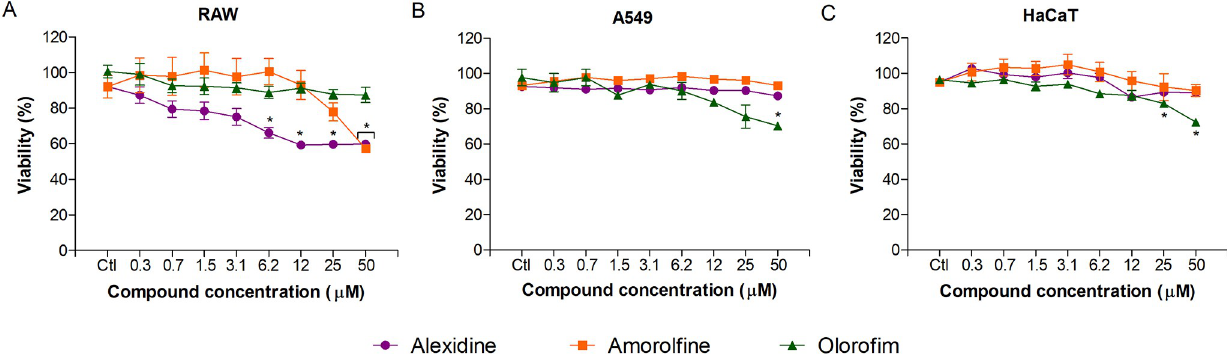
Fig 7. Cytotoxicity assay. Monolayers of RAW 264.7, A549 and HaCaT cells were incubated for 24 h in the presence of 0.3–50 μ M of alexidine, amorolfine or olorofim, and cell viability was measured by neutral red method. � p < 0.05. Experiments were performed in triplicate, in three independent experimental